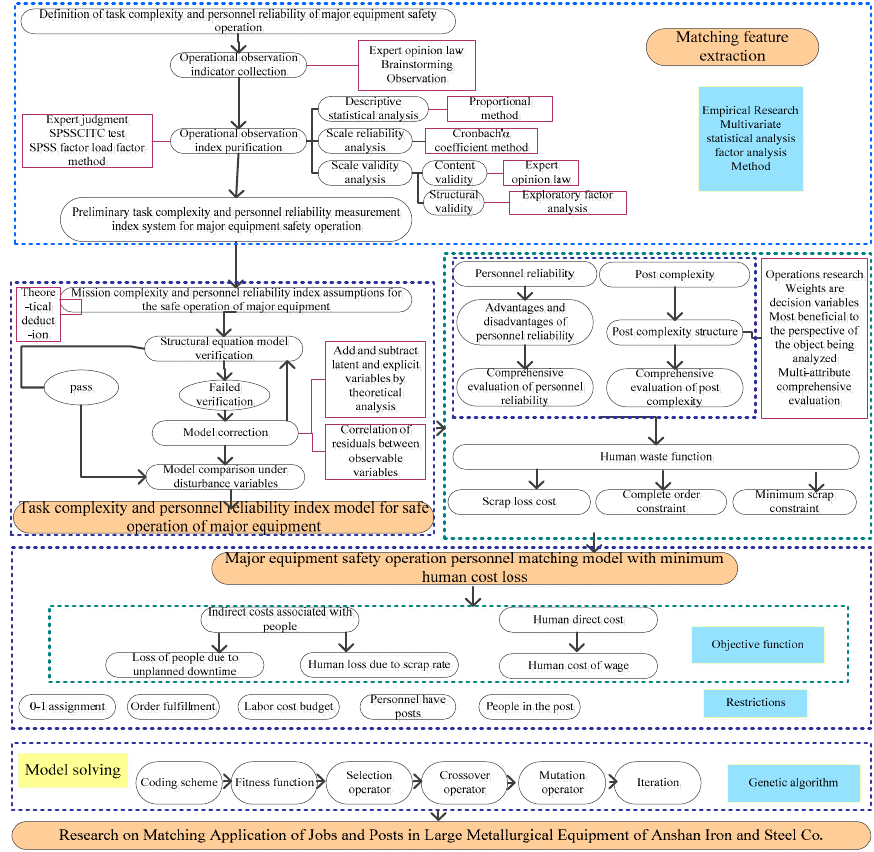
Figure 3. Implementation process method.